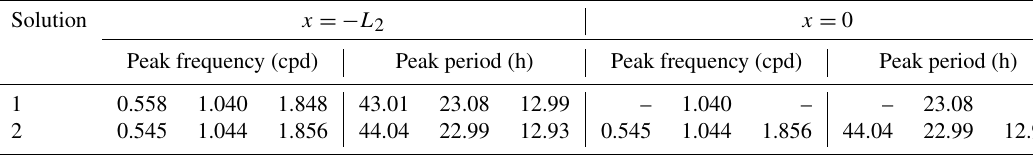
Table 3. The resonant frequencies and corresponding periods at x = − L 2 and x = 0 . Solution